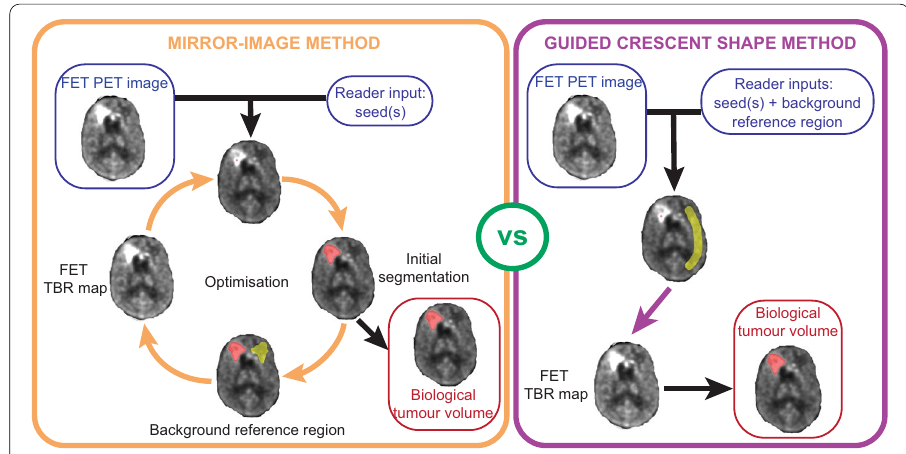
Fig. 1 Schematics of the algorithm for the two methods. Mirror-image method involving an iterative optimisation process. Guided crescent-shape method involving a linear process. 18 F-Fluoroethyl- l -tyrosine; TBR tumour-to-brain FET = =